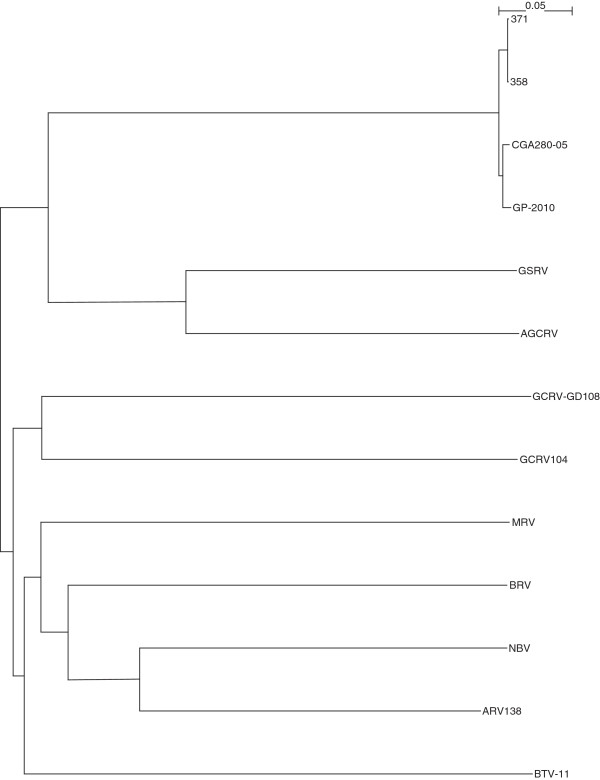
Phylogeny of homologous segment M3 shared by piscine reovirus (PRV) and selected members of familyReoviridae.